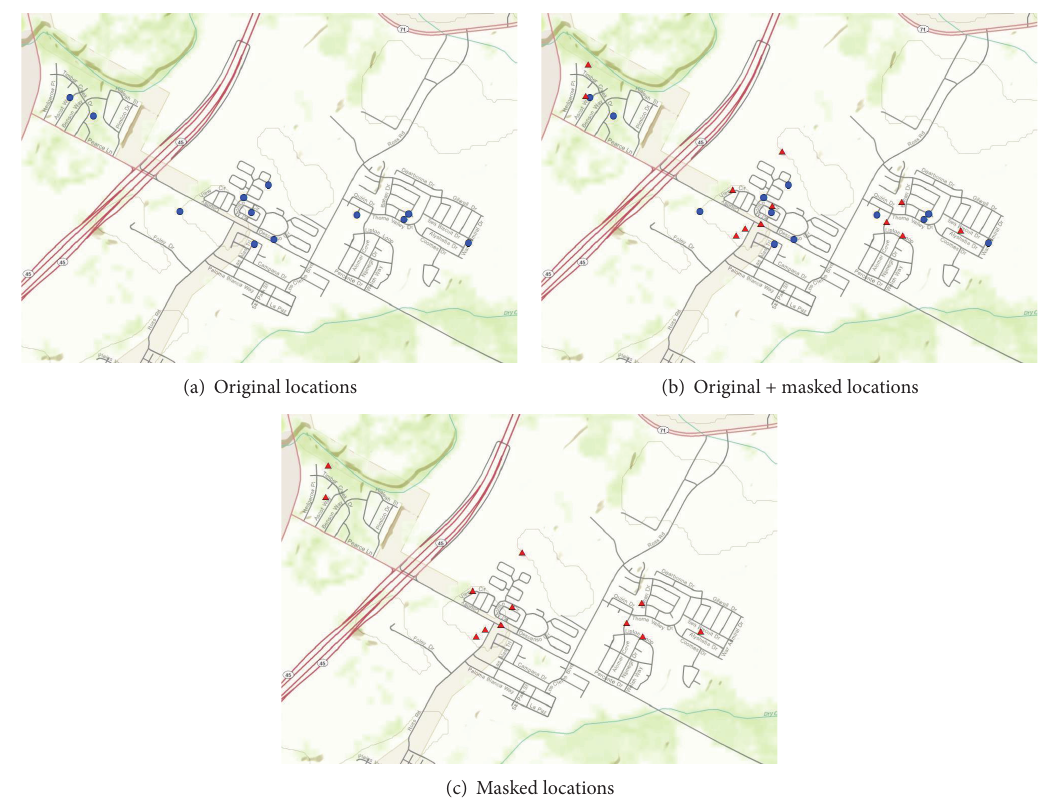
Figure 4: Conceptual illustration of geographic masking. A set of original locations (a) is created using address geocoding or field data collection using GPS. These locations correspond very closely to the residences of interest, although a certain amount of error might be present. For each location, a masked representation is created (b) by displacing the original location using one of several algorithms. Most algorithms include a certain degree of randomness in the displacement. The original locations are removed from the dataset, resulting in a set of masked locations (c) for publication and distribution purposes. The set of masked locations has the same number of observations as the set of original